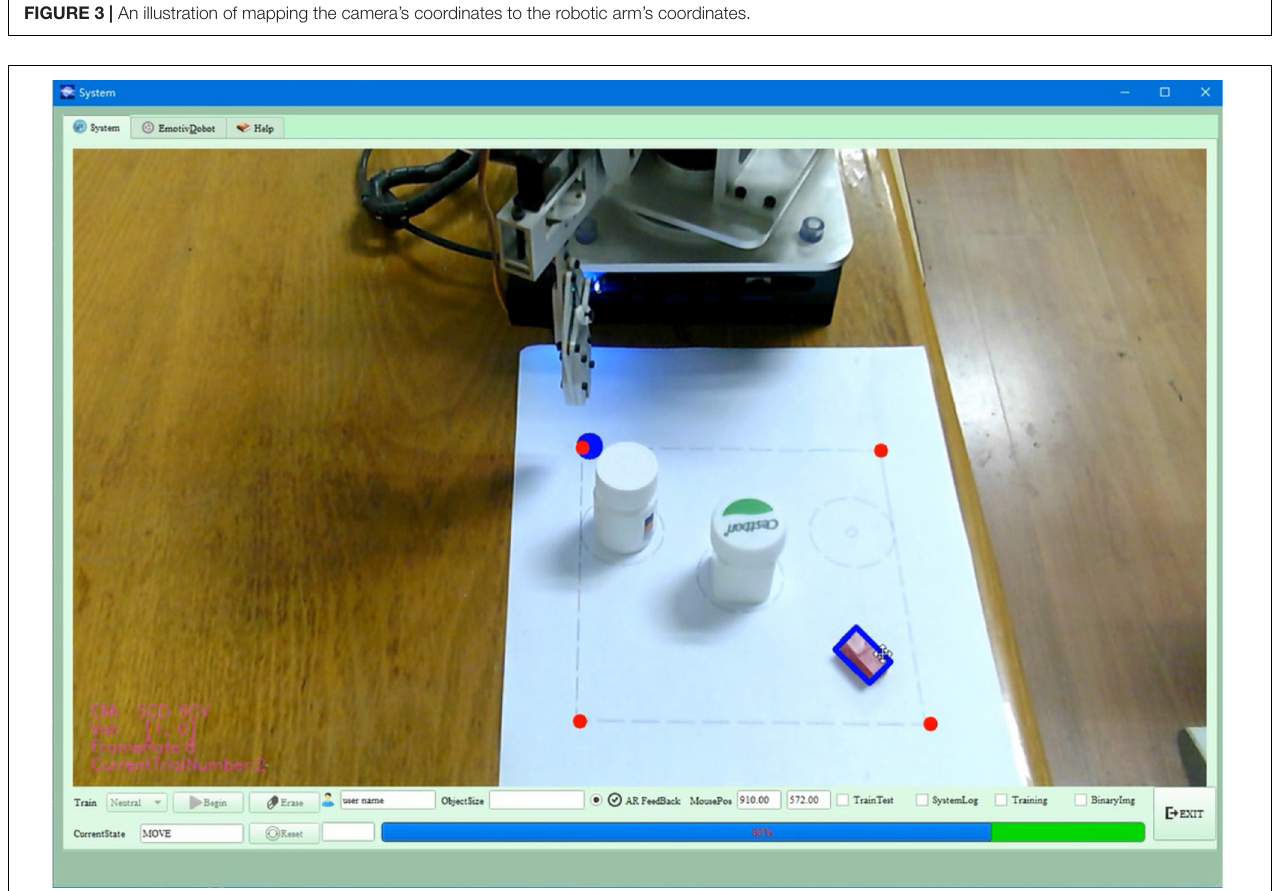
FIGURE 3 | An illustration of mapping the camera’s coordinates to the robotic arm’s coordinates.